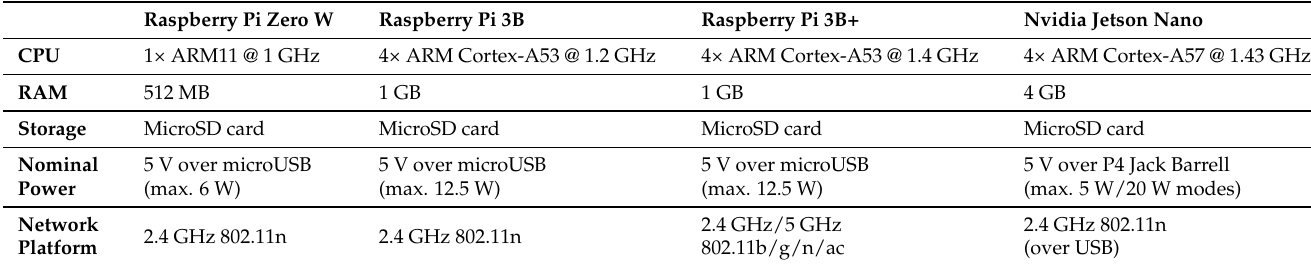
Table 1. Hardware specifications for the edge AI server node